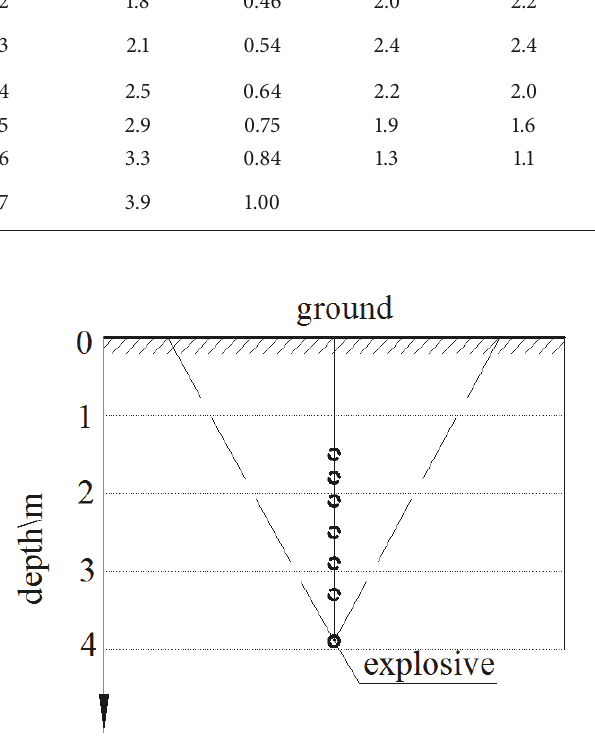
Figure 2: Distribution of the locations of the explosives.